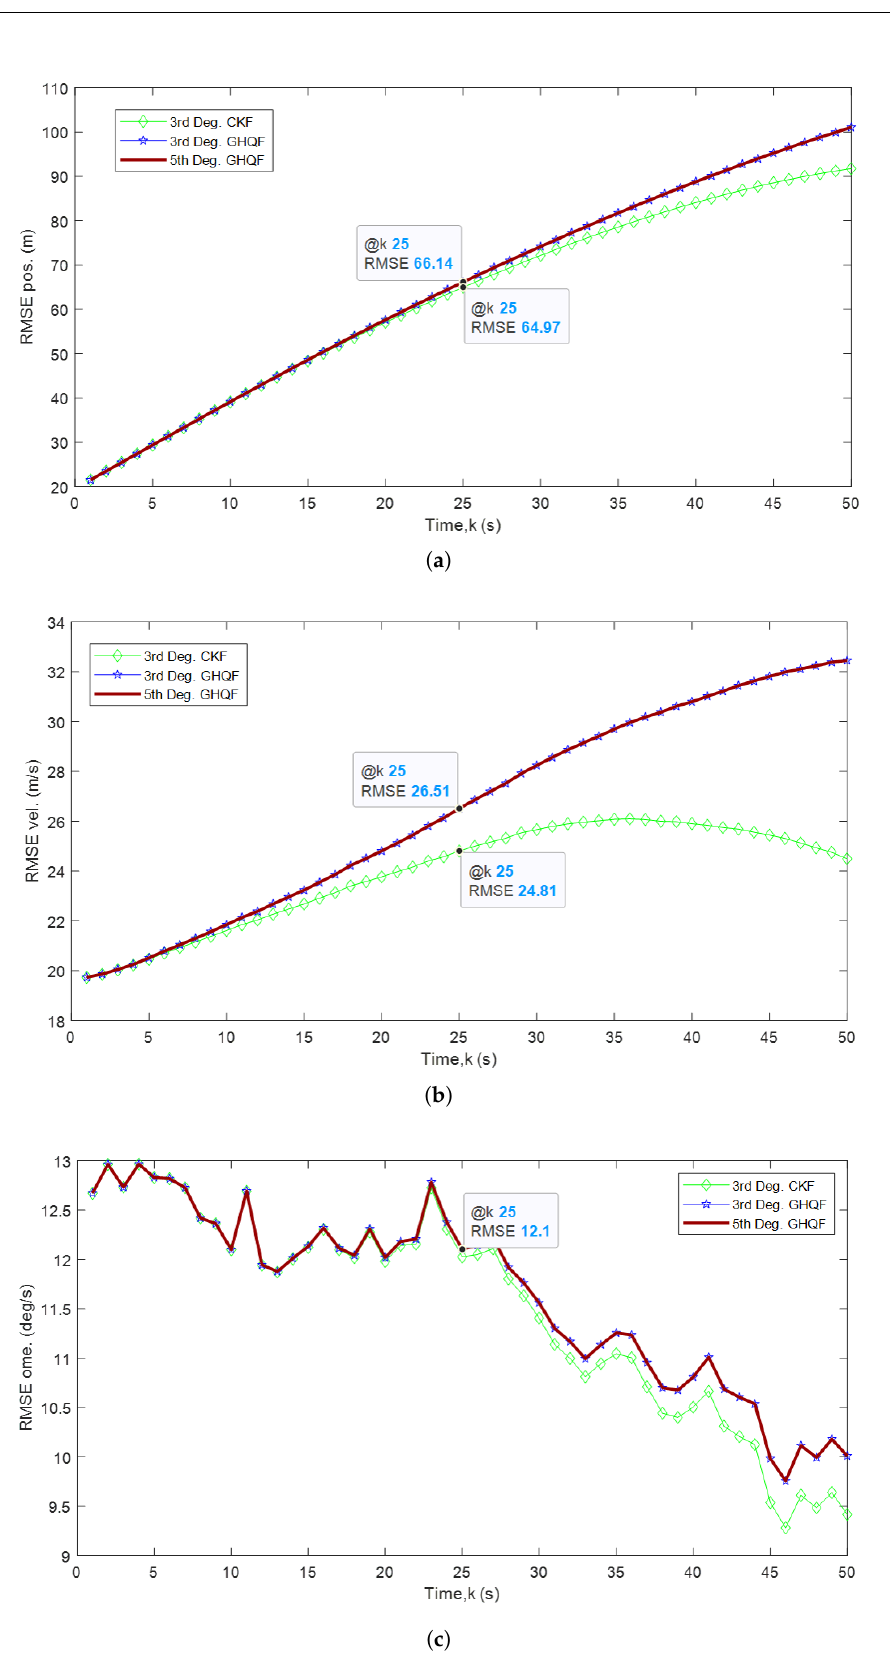
Figure 16. RMSE for GHQF approach based on TDOA: The figure concludes the performance results of GHQF 5th compared to GHQF 3rd, and CKF 3rd based on TDOA produced a high divergence of RMSE and difficulty in tracking the UAV as RFI emitter when using TDOA measurement. ( a ) RMSE of position. ( b ) RMSE of velocity. ( c ) RMSE of